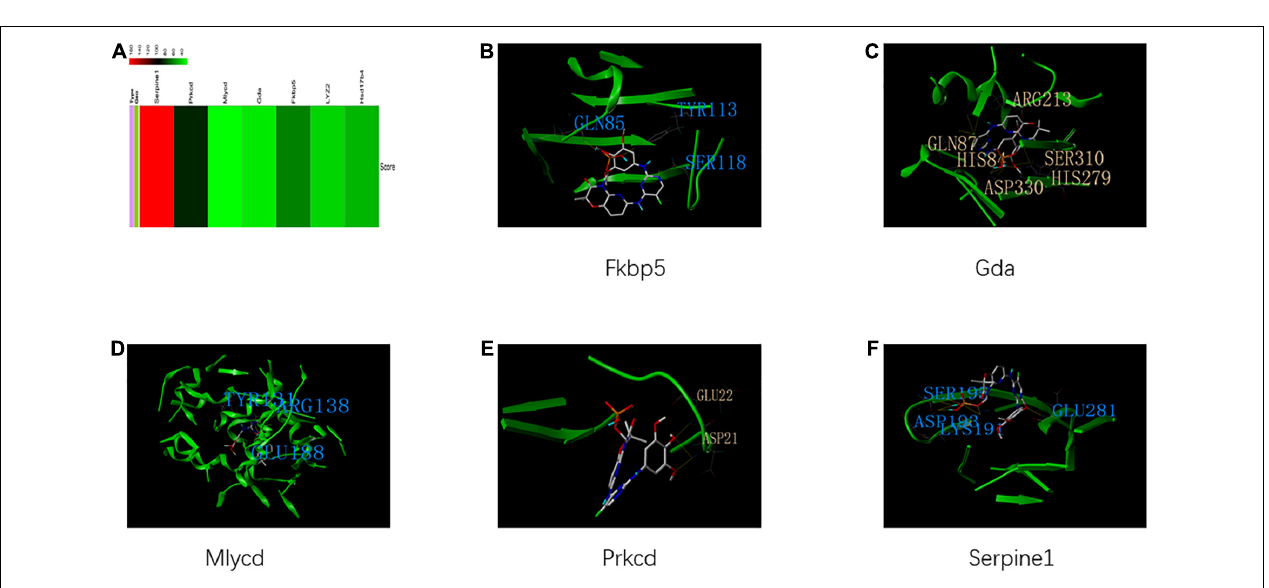
FIGURE 9 | Housekeeping genes and housekeeping interactions. (A) The heatmap of score between heart failure with preserved ejection fraction (HFpEF) and genes of housekeeping genes and housekeeping interactions. (B) The binding site and interactions between fostamatinib and FKBP 5 . (C) The binding site and interactions between fostamatinib and GDA. (D) The binding site and interactions between fostamatinib and MLYCD. (E) The binding site and interactions between fostamatinib and PRKCD. (F) The binding site and interactions between fostamatinib and SERPINE